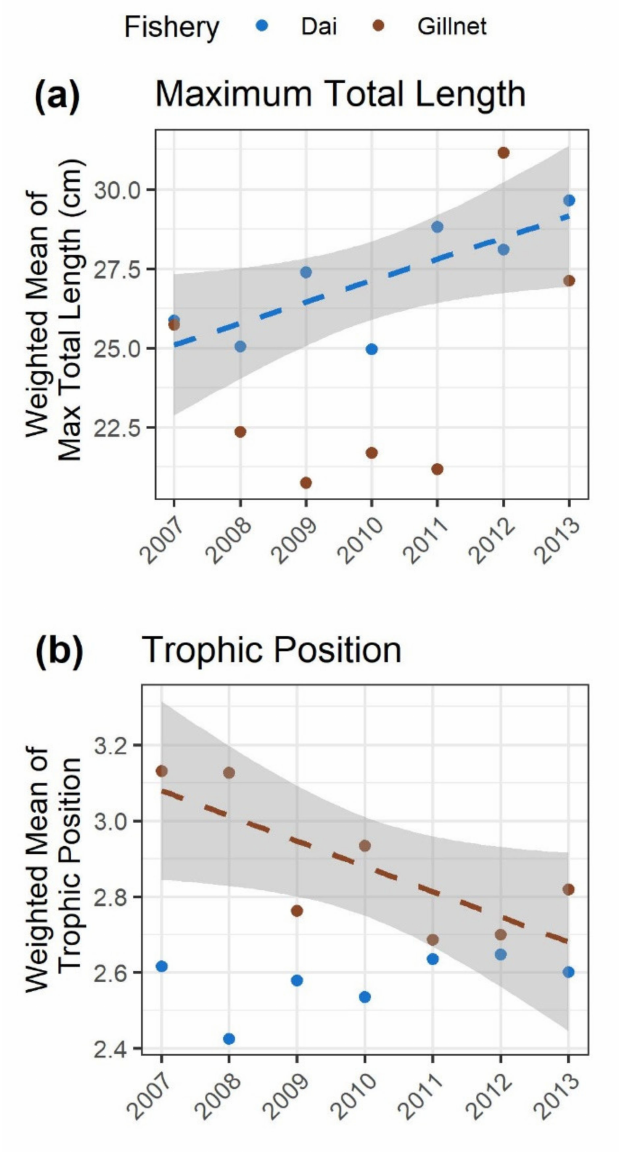
Figure 6. Changes in ( a ) weighed mean of the maximum total length and ( b ) weighted mean of trophic position over seven years in the Dai and gillnet fishery. Significant linear regressions are plotted, and grey areas represent one standard